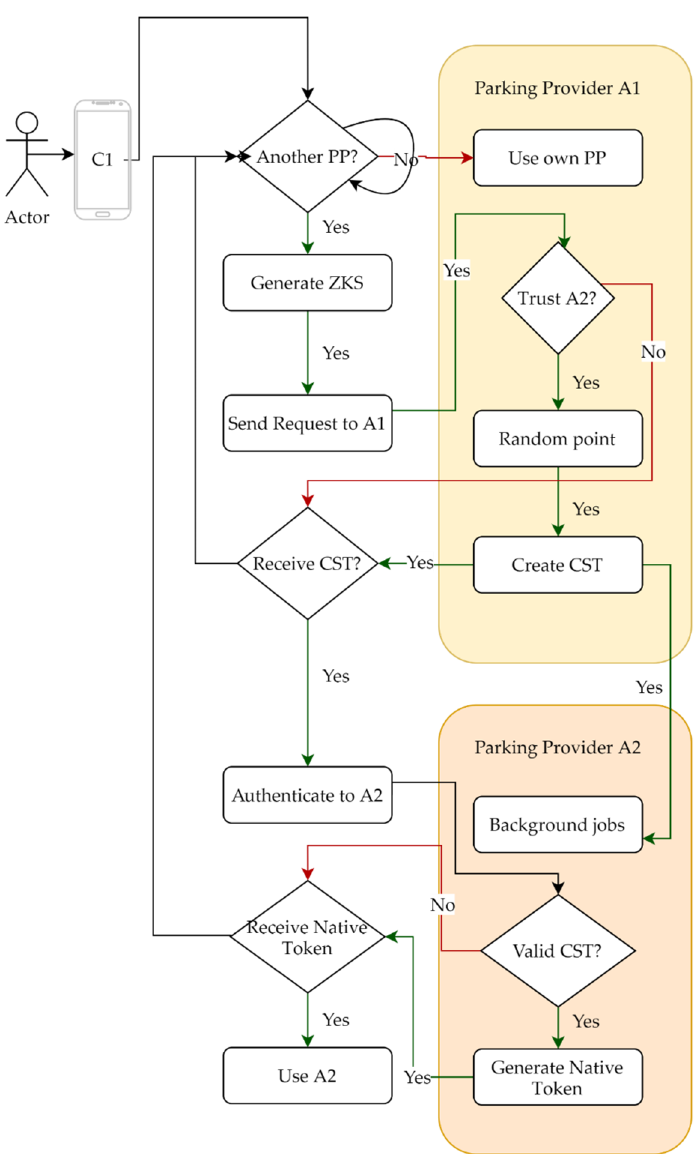
Figure 5. Mobile app requests PP one to envelop ZK signature and notify PP two.